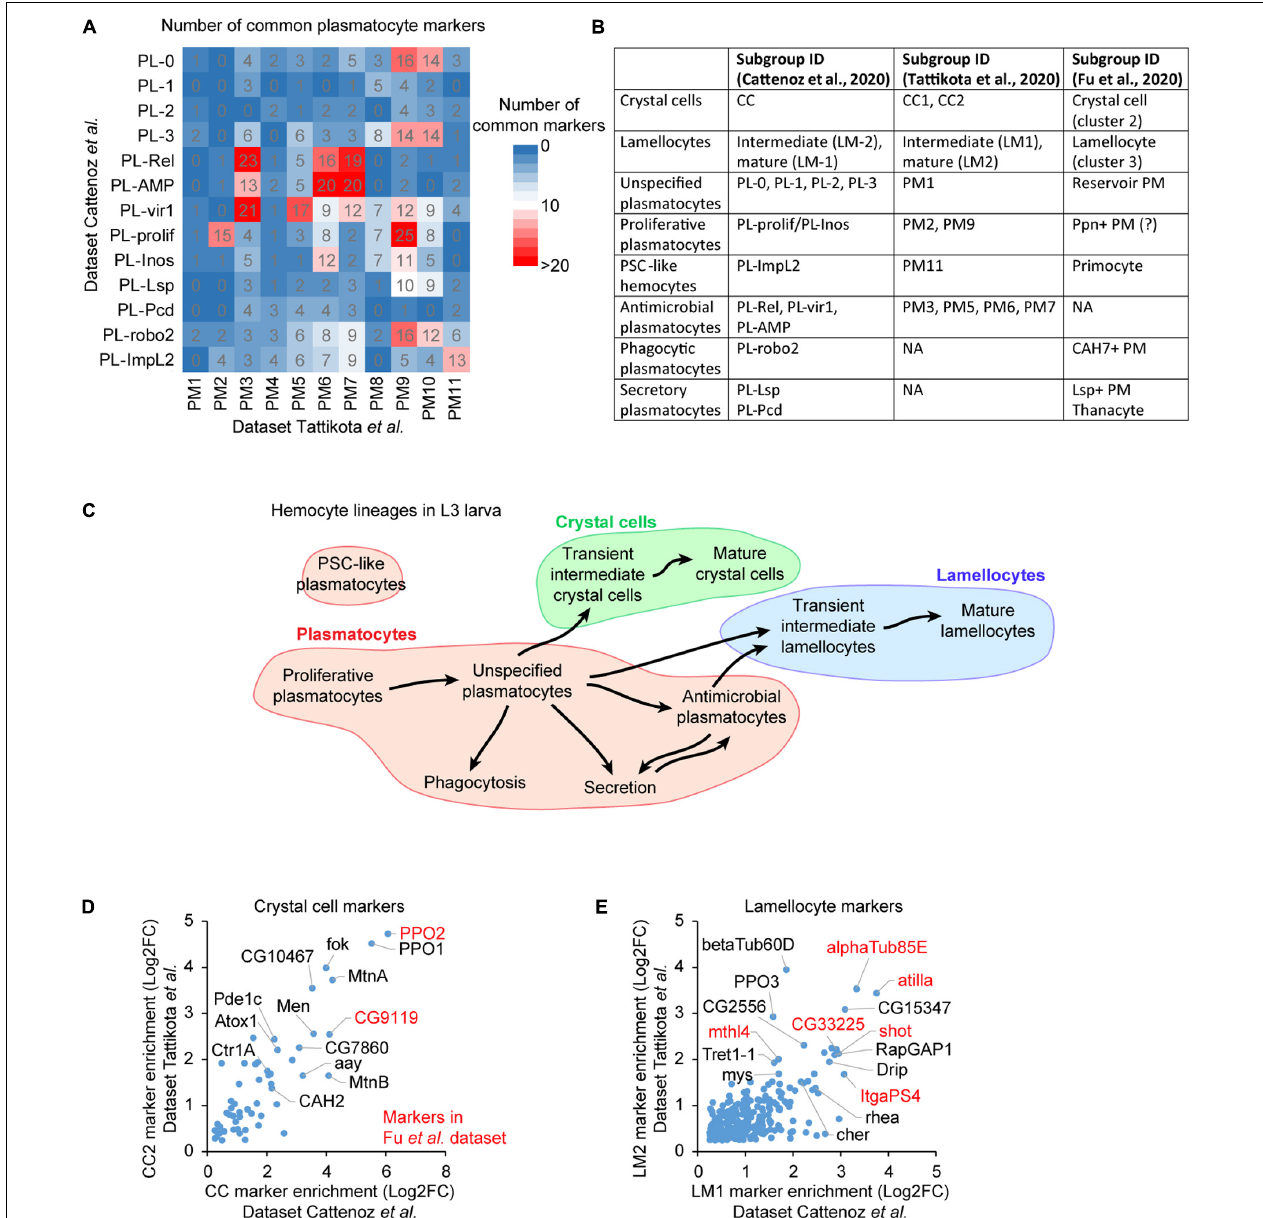
FIGURE 2 | Defining a consensual repertoire of the hemocyte subgroups. (A) Number of common markers between the plasmatocyte subgroups identified in Cattenoz et al. (2020) (rows) and in Tattikota et al. (2020) (column). The number of markers is highlighted by the color gradient (from 0 in blue to > 20 in red). (B) Concordance amongst the hemocyte subgroups across the three datasets. (C) Outline of the lineage predictions among the hemocyte subgroups, based on the prediction analyses in Cattenoz et al. (2020) and Tattikota et al. (2020) and on the present comparative analysis. The proliferative plasmatocytes are at the origin of most hemocytes, they give rise to a large pool of unspecified plasmatocytes that further differentiate to acquire specific properties such as phagocytosis, secretion or antimicrobial peptide production. Subsets of unspecified plasmatocytes and antimicrobial plasmatocytes transdifferentiate to produce crystal cells or lamellocytes. (D) Scatter plot representing the enrichment levels of the crystal cell markers common to the subgroups CC2 (y-axis) from Tattikota et al. (2020) and CC (x-axis) from Cattenoz et al. (2020). The Log2 fold change (Log2FC) of the enrichment is represented. The markers with the strongest enrichment are indicated on the graph, those also identified in Fu et al. (2020) are highlighted in red. (E) Scatter plot representing the enrichment of the lamellocyte markers in the indicated subgroups. The representation is as in panel (D).